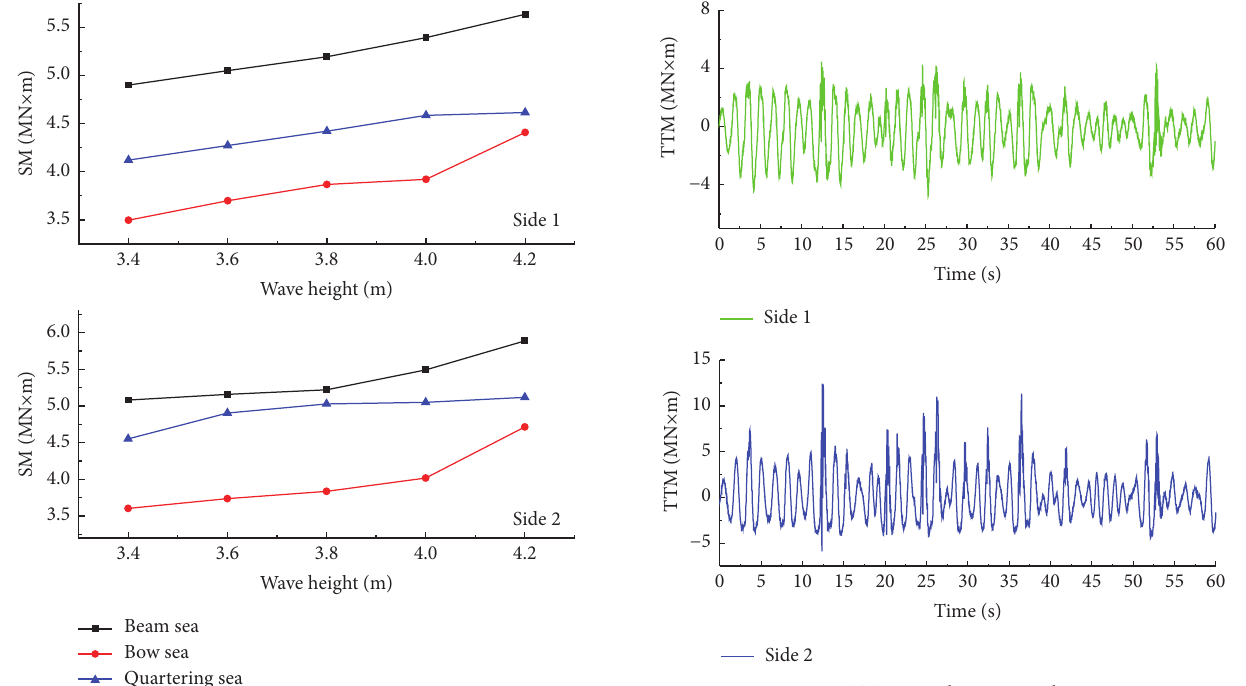
Figure 34: Splitting moment in different wave height.